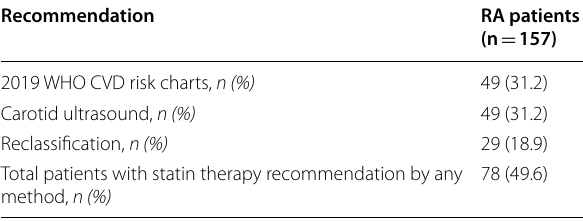
Table 3 Patient with statin therapy